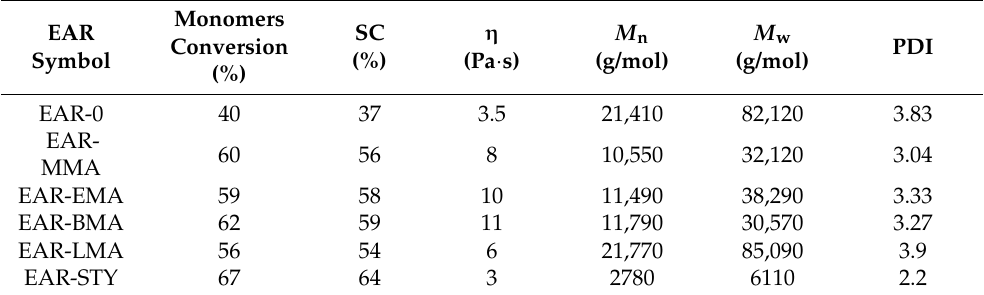
Table 3. Monomers conversion according to NMR data, solids content, dynamic viscosity, average molecular weights and polydispersity index of